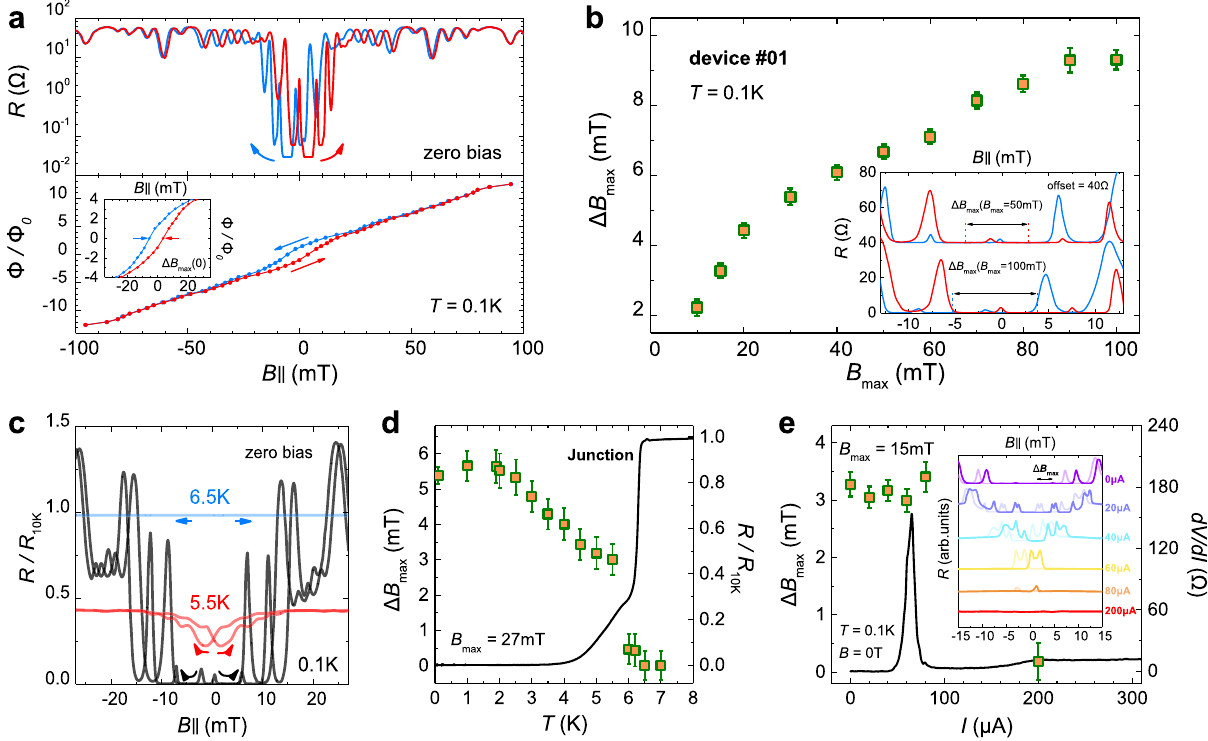
Fig. 3 Evolution of the barrier magnetization in the Josephson junctions. a (upper) Hysteretic in-plane R (log-plot) and (lower) the fi eld dependence of trapped fl ux in the junction of device #01 with B max of 100 mT at 0.1 K. The latter depicts the magnetization curve of the barrier itself. The largest hysteresis Δ B R is 9.3 mT. The inset is a zoom-in plot near the zero magnetic fi eld. b Dependence max estimated from the central position of its zero-order minimum of of Δ B max about B max . It performs a continuous increase and fi nally converges at higher fi elds. The inset is the comparison of hysteretic R and Δ B max with a B Ω for clarity). Error bars indicate the standard error in readouts of the hysteresis by resolutions of data max of 50 and 100 mT (offset of the former is 40 points, and below are the same. c In-plane R compared between the superconducting state and normal state. Magnetic hysteresis shrinks with temperature increasing, then disappears above T c of NbSe 2 , suggesting that the magnitude of superconducting interference with temperature re fl ects in the size of hysteresis. d Temperature dependence of normalized junction R and Δ B max ( B max = 27 mT). Value of the latter one remains almost unchanged below 2 K and gradually decreases up to 6.4 K. e Δ B max ( B max = 15 mT) at different d.c . bias current along with zero fi eld d V/ d I curve at 0.1 K. Δ B max is identical (within range of error) below 100 μ A but virtually zero at high bias, indicating the disappearance of hysteresis. The inset is the hysteretic R at 0 – 200 μ A bias current from superconducting to the normal state (stacked and colored for